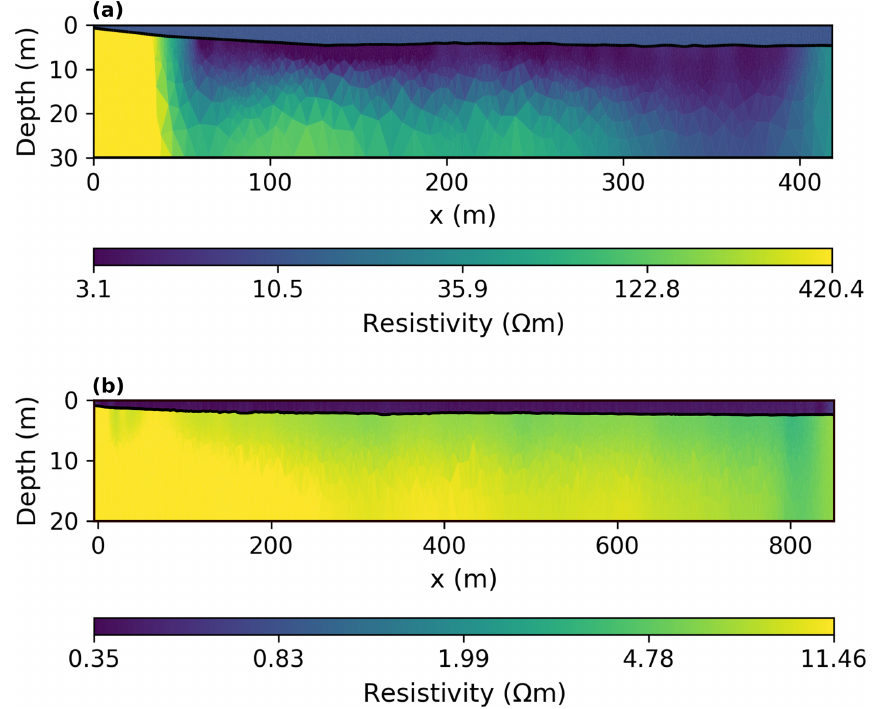
Figure A1. Smooth inversion models for (a) the Bykovsky and (b) Drew Point data sets. To enhance the resistivity contrast in our ERT models presented in panels (a) and (b) , we limited the lower and upper resistivities considering quantiles 0.04 and 0.96,